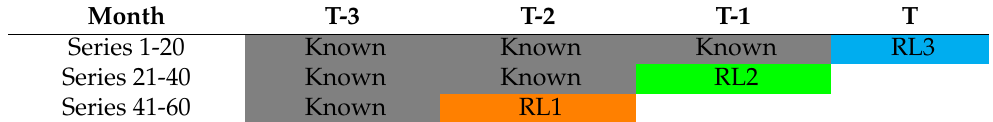
Table 2. Data releasing structure for simulation study when nowcasting quarter K + 1’s GDP in month T. “RL” represents release. Orange color represents release 1, green represents release 2, and blue represents release